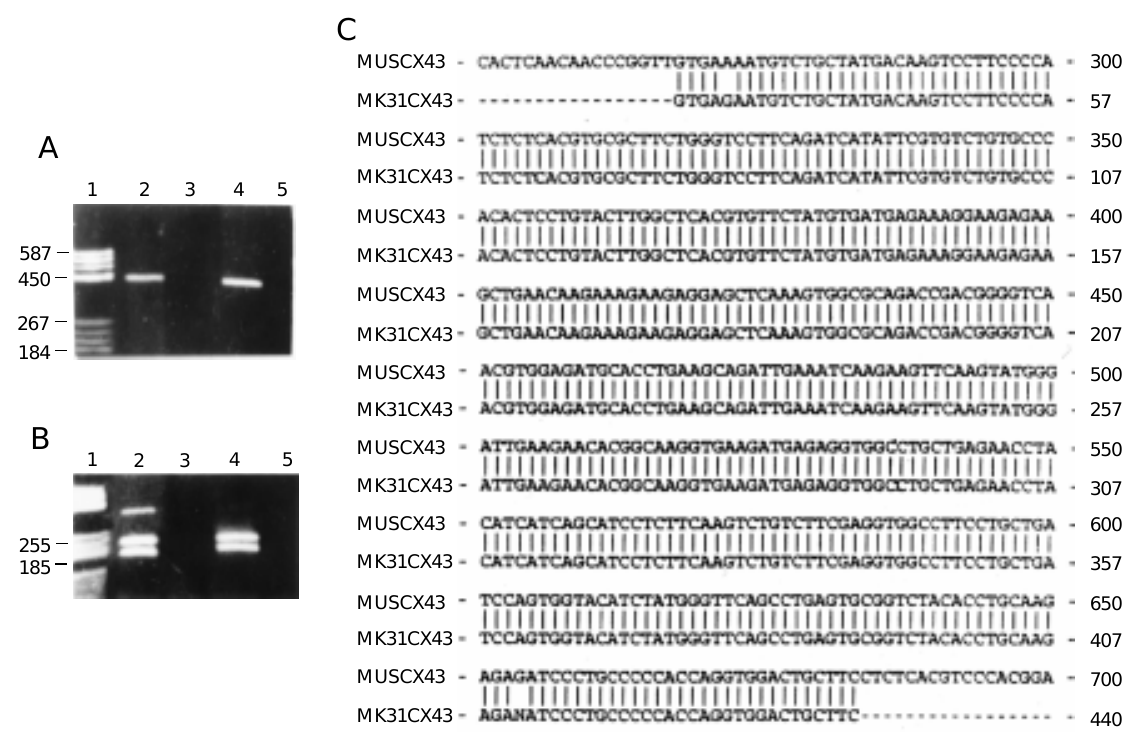
Figure 3 - Connexin detection in a neural cell line (MK31 cell line). Bench-top protocol of our methodology and potential applications. A , Screening connexin identity in a cell line using RT-PCR assays. First generation of PCR products indicates that the amplified DNA sequences belong to group II (A2,4). B2 , Second generation of PCR products indicates the expression of Cx43 in these cells. Lane 4 is the PCR product of Cx43 from rat heart and lane 5 is its corresponding negative control. B , Lanes 2,4 show the presence of restriction products of Cx43 after Hin cII was used. Lane 3 is a negative control for the cells. The negative controls were run in PCR without reverse transcriptase to verify that genomic DNA was not present (lanes 3,5). C , Sequencing the RT-PCR products revealed the presence of Cx43 (99.7% identical) in these cells. Terminology: Mouse heart Cx43 sequence (MUSCX43) and sequence found in the neural cell line (MK31CX43). Molecular markers (A1, B1).